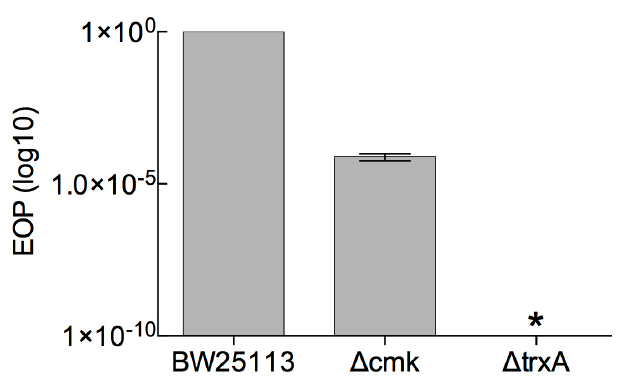
Figure 2. Efficiency of plating for T7 on E. coli BW25113 , E. coli BW25113 Δ cmk and E. coli BW25113 Δ trxA strains. EOP was determined with respect to a reference E. coli strain BW25113. EOP data were log 10 transformed and are presented as the mean of three independent experiments, n = 3. An asterisk indicates that the EOP was below the detection limit which is < 1.